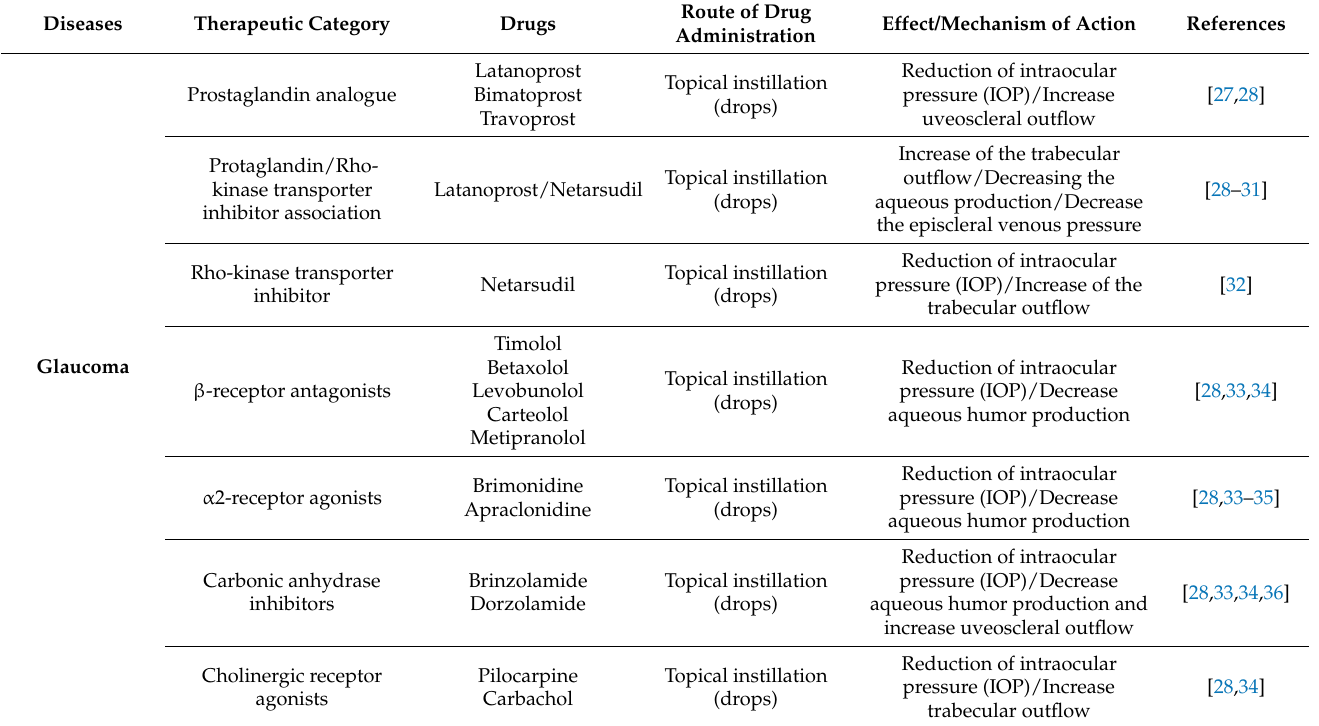
Table 1. Some drugs currently used in major ocular